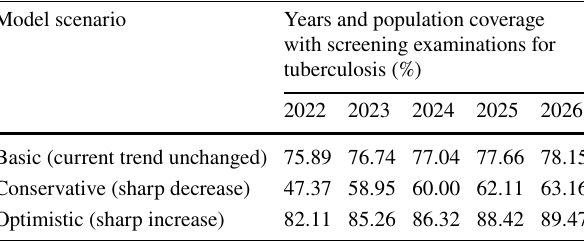
Table 1 Predictive values of the coverage with TB screening exami-